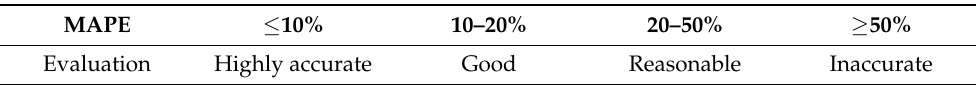
NDGM, NGBM, Grey Verhulst, OP-NGBM, and OP-FANGBM are lower than 10%,